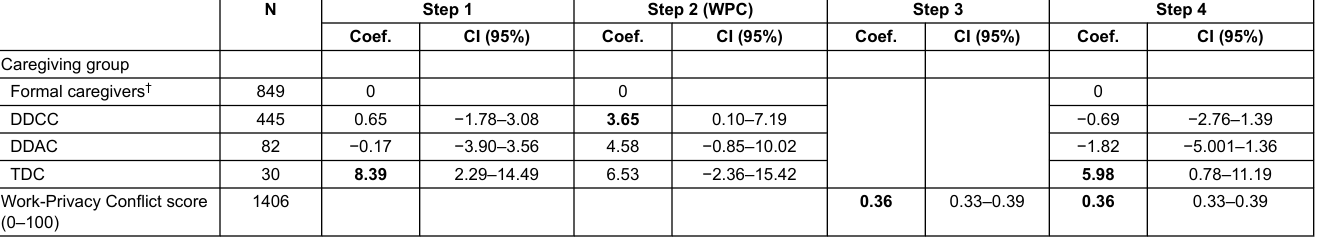
Table 2: Burnout risk for caregiving groups: four-step mediation